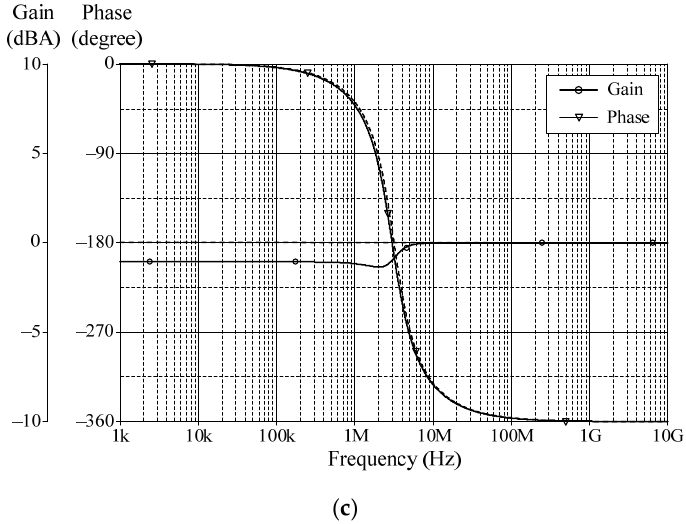
Figure 7. Frequency characteristics for CM (simulated in solid line, theoretical in dashed line): ( a ) LP, BP, and HP; ( b ) BS; ( c ) AP.